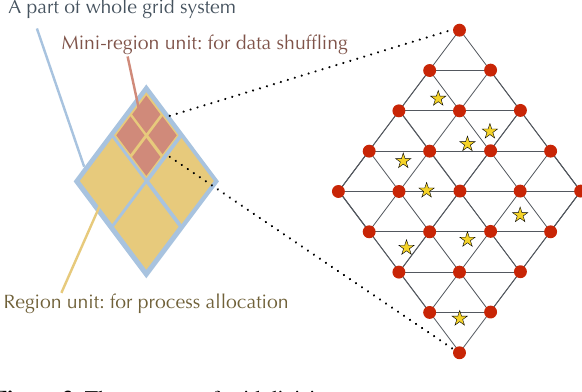
Figure 3. The concept of grid